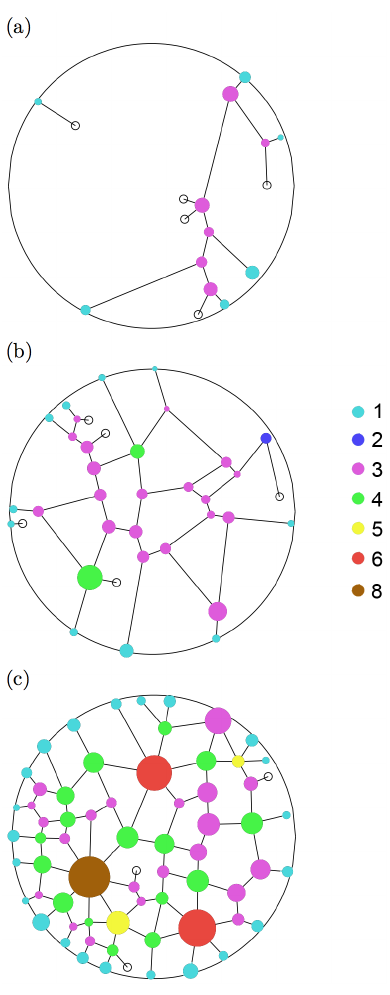
Figure 4. Examples of experimental networks dug by the ants in 72 hours depending on the number of workers (a) A ~ 50 , (b) A ~ 100 , (c) A ~ 200 . The corresponding values of the meshedness M ( t ) are respectively 0.0, 0.092 and 0.194.